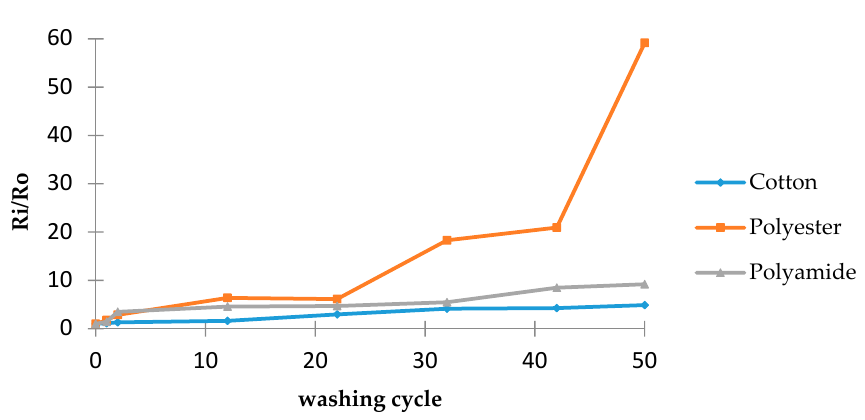
Figure 2. The evolution of R i /R 0 versus washing cycle.